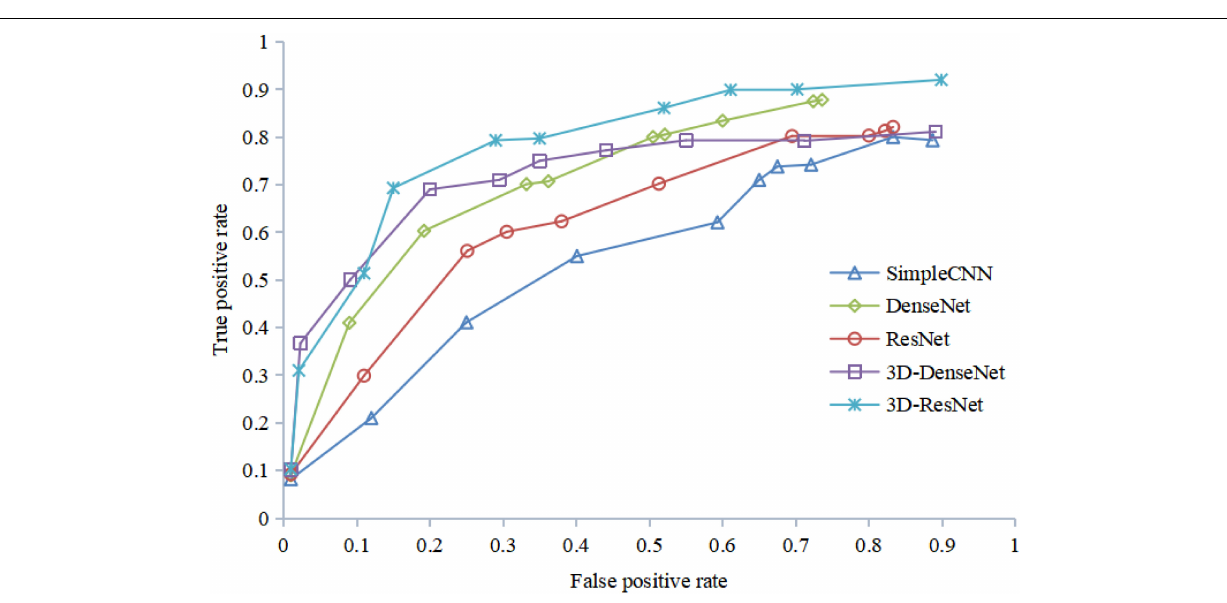
FIGURE 13 | ROC curves with FRN-Net for different backbones of the validation